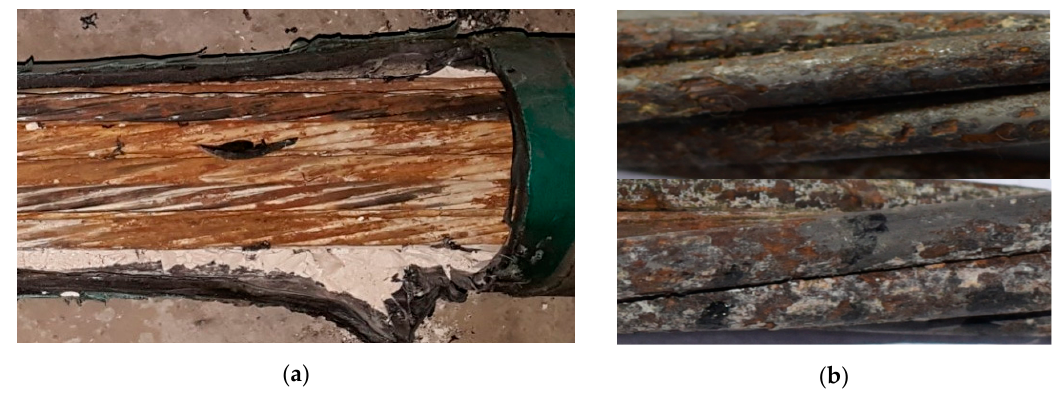
Figure 1. Observed corroded strands in existing bridges: ( a ) corroded tendon; ( b ) corroded strand.